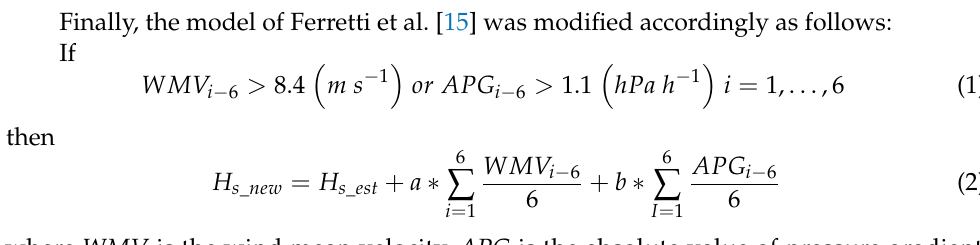
Figure 8. H s measured (blue line), pressure gradient (violet line) and wind velocity (orange line) during the Adrian storm.